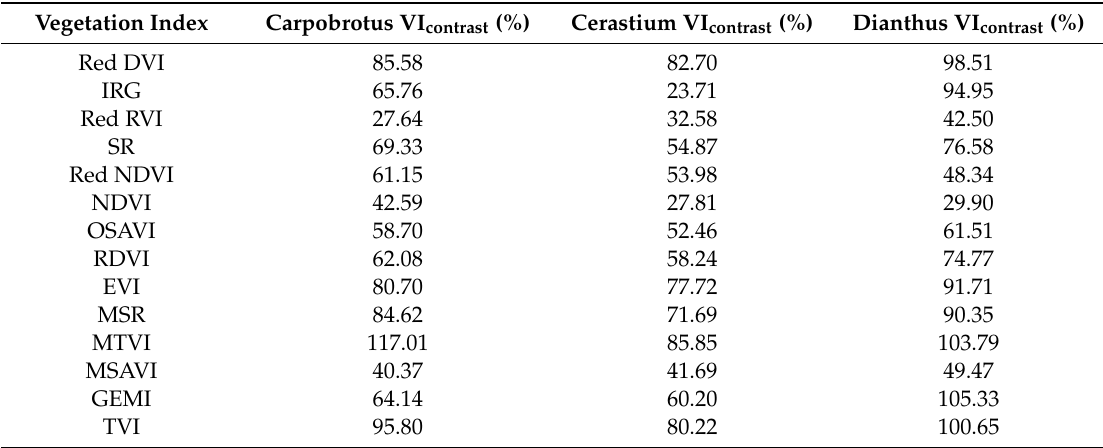
Table 2. Vegetation indices’ (VI)